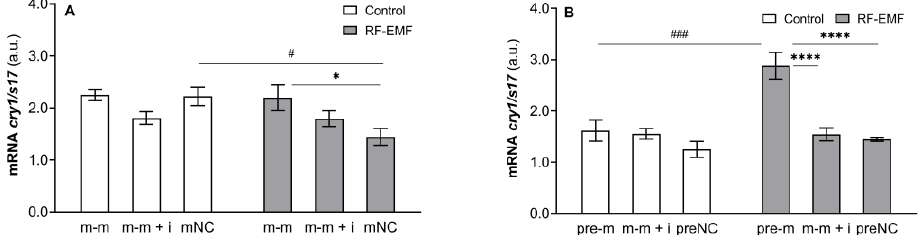
Figure 2. Effect of miR-34a administration on cry1 mRNA expression in DLD1 cells under control and RF-EMF conditions. Cells were transfected with ( A ) miR-34a-5p (m-m), ( B ) pre-miR-34a (pre-m), mimic of mature miR-34a together with the miR-34a inhibitor (m-m + i) or corresponding negative control of mature and pre-miRNA (mNC and preNC, respectively). The data were relativised to the corresponding negative control measured under control conditions and presented as the mean ± SEM (n = 4). a.u.—arbitrary units. Two-way ANOVA, Tukey’s post hoc test, * p < 0.05, **** p < 0.0001 — comparison between groups transfected with different oligos within the control or RF-EMF treatment. Two-way ANOVA, Šídák’s multiple comparisons test, # p < 0.05, ### p < 0.001 — comparison between the control and RF-EMF groups.